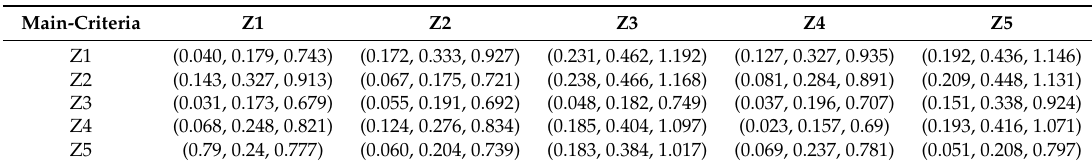
Table 10. The total relation fuzzy matrix of the main